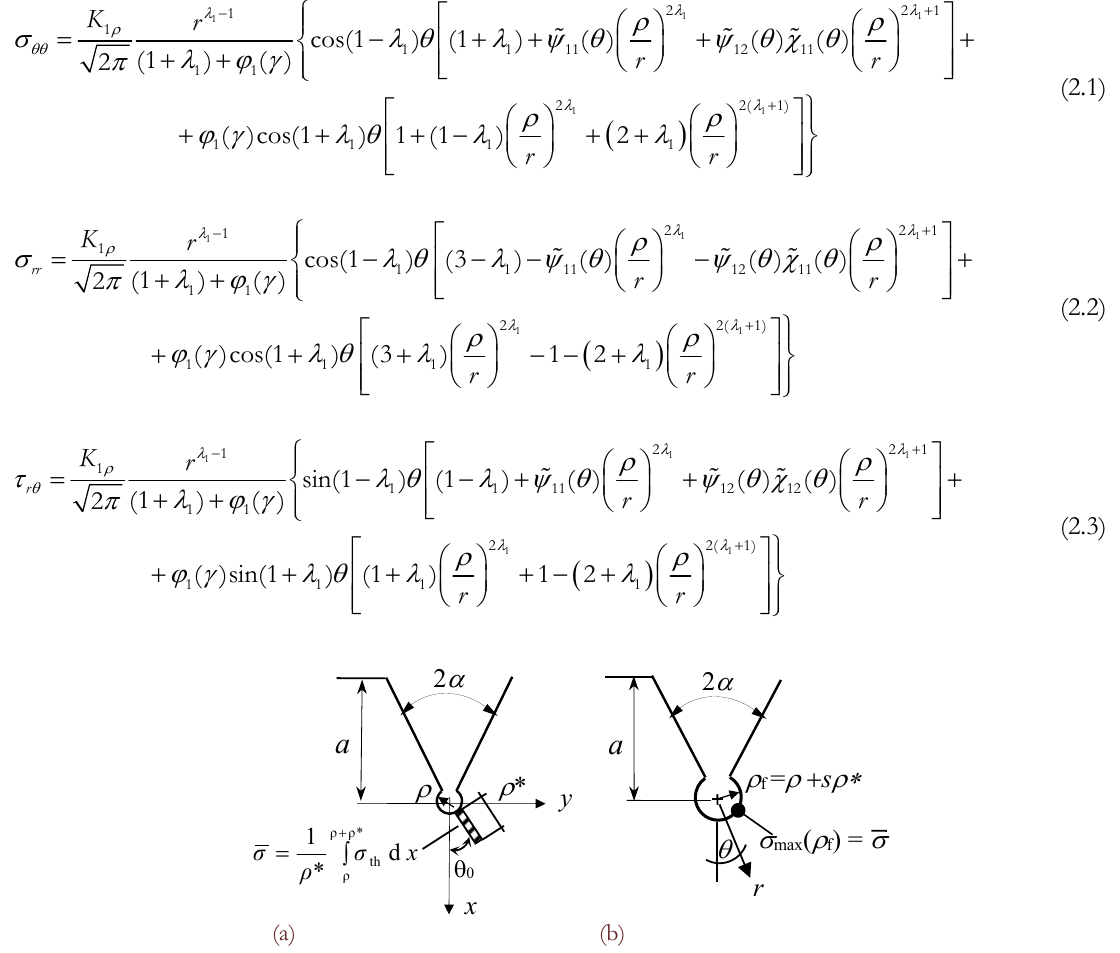
Figure 1: Fictitious notch rounding concept applied to mixed mode loading (mode 1+2): real root hole notch with stress averaged over  * in direction of crack propagation (a) and substitute root hole notch with fictitious notch radius  f producing  max = 